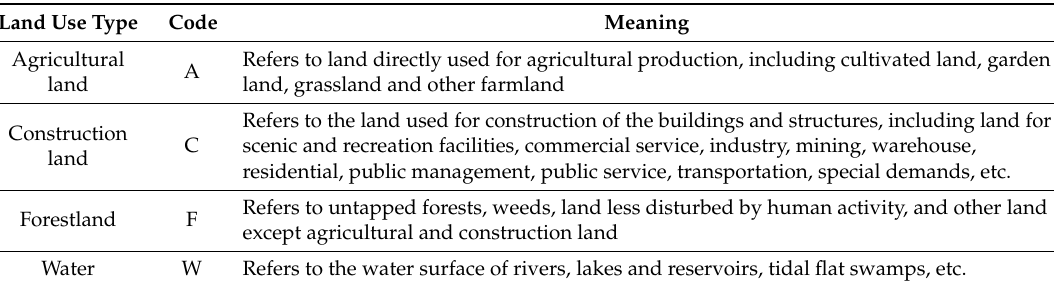
Table 1. Classification of land use